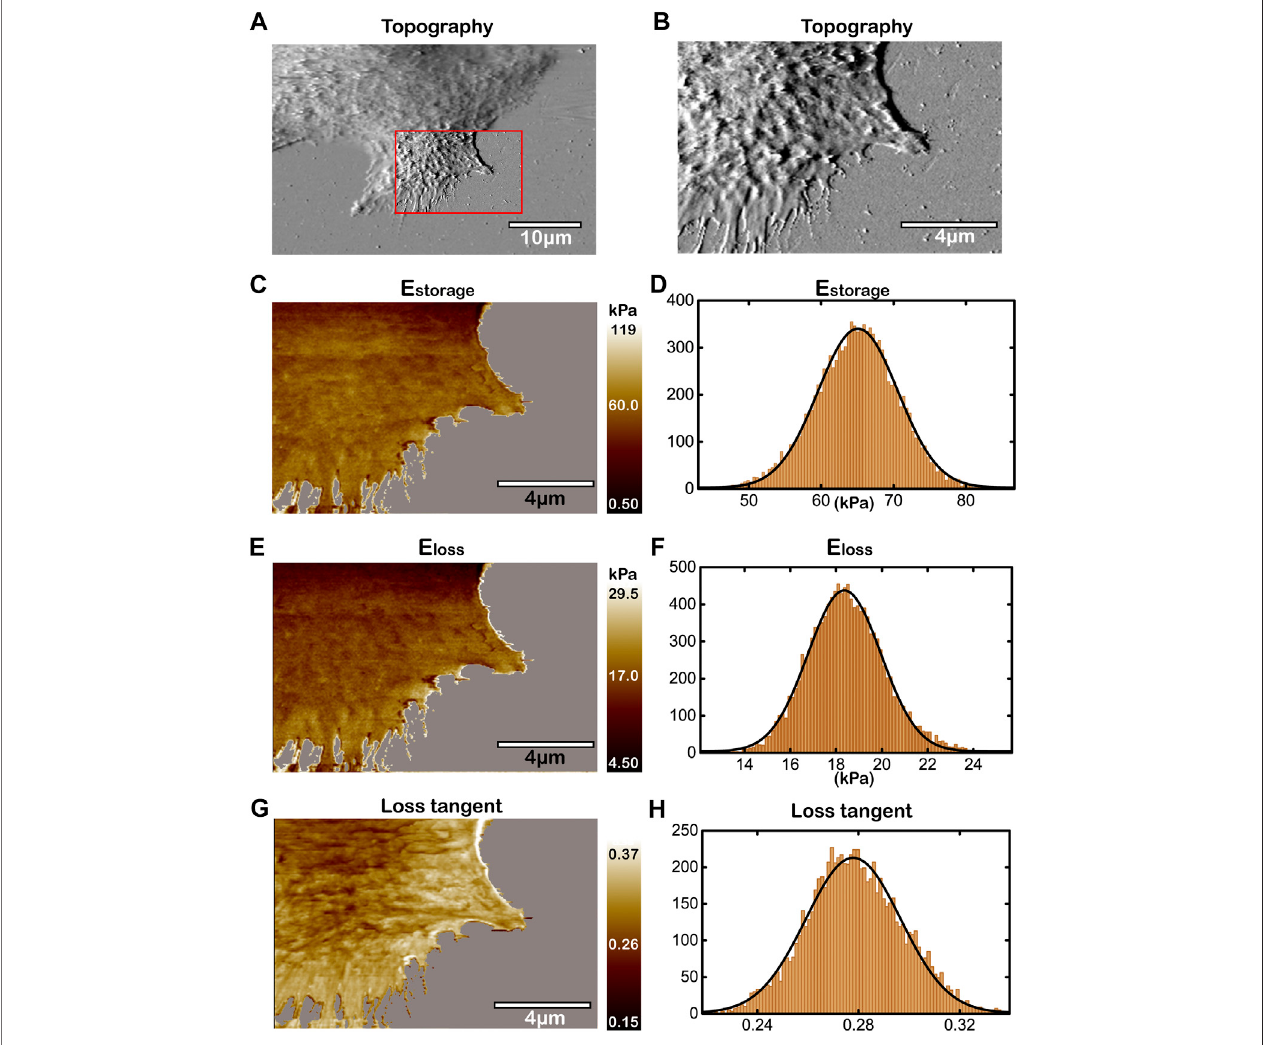
FIGURE4| TopographyandtheviscoelasticityofHuh-7cellsatpH7.4. (A) Topographyofcelledge. (B) High-resolutiontopographyoflamellipodiumregionwithin the red box in (A) . (C , E , G) Mapping of E storage (C) , E loss (E) , and loss tangent (G) simultaneously obtained byAM-FM AFM. (D , F , H) Histogram analysesof the measured E storage , E loss , and loss tangent in (C) , (E) and (G) , respectively.